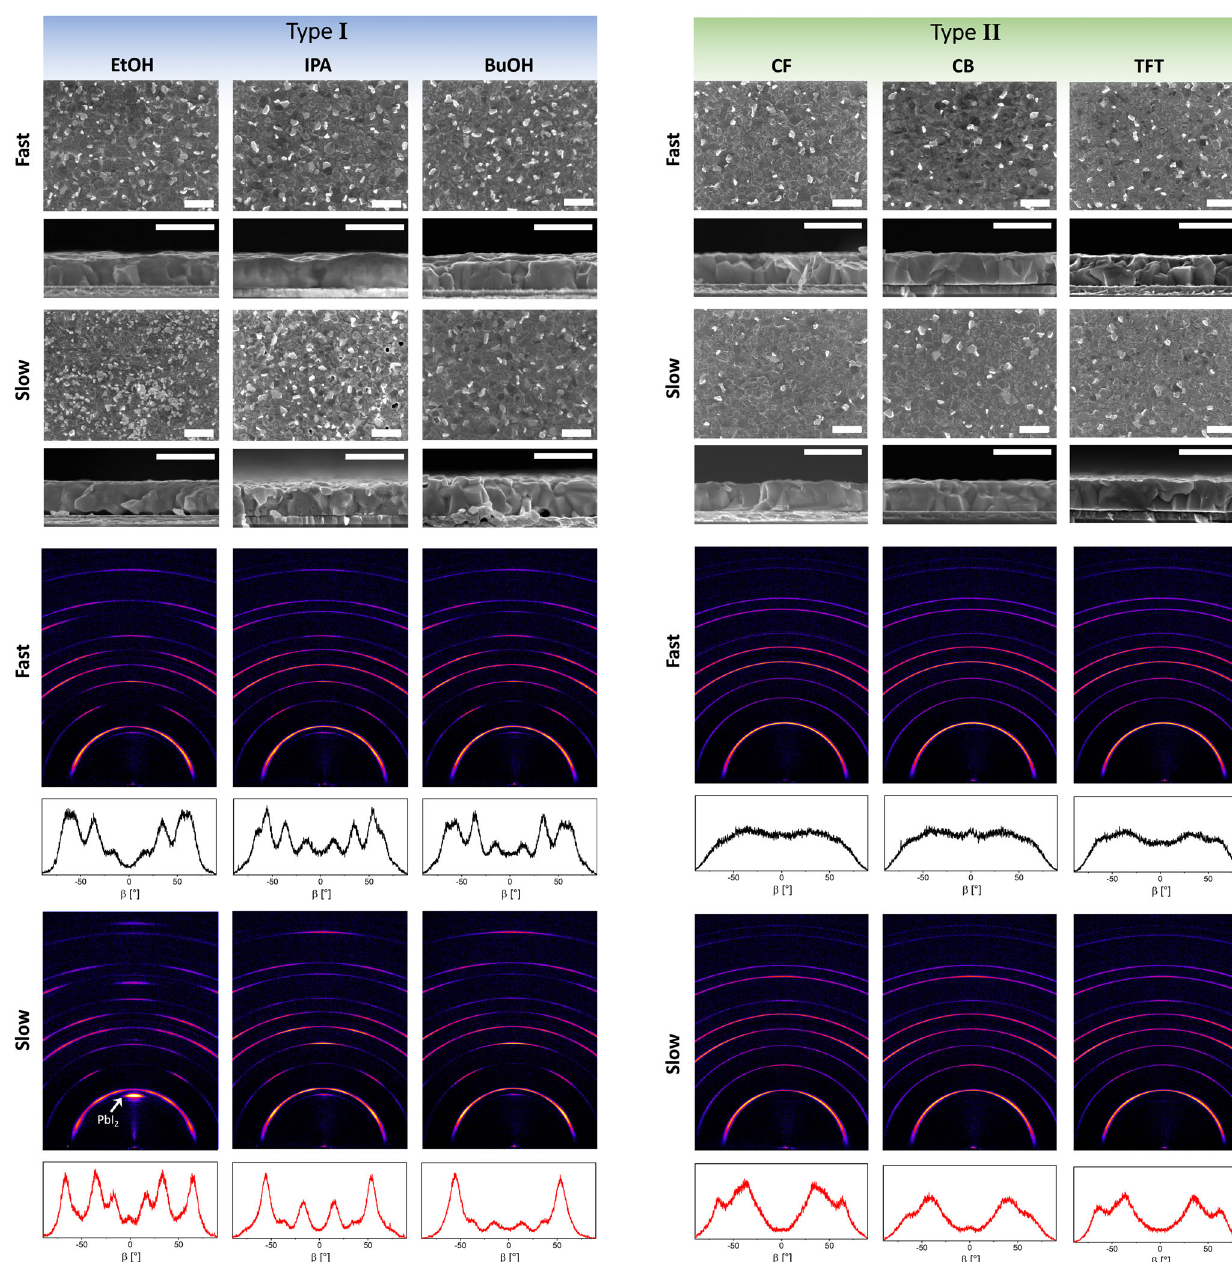
Fig. 4 Microstructural and structural characterization of perovskite fi lms deposited by type II antisolvents. Top: surface and cross-sectional scanning electron microscopy images of perovskite fi lms formed from selected type II antisolvents (CF, CB, and TFT). Scale bar is 1 μ m. Bottom: 2D XRD maps and corresponding ß integration of the (100) re fl ection to visualize changes in grain